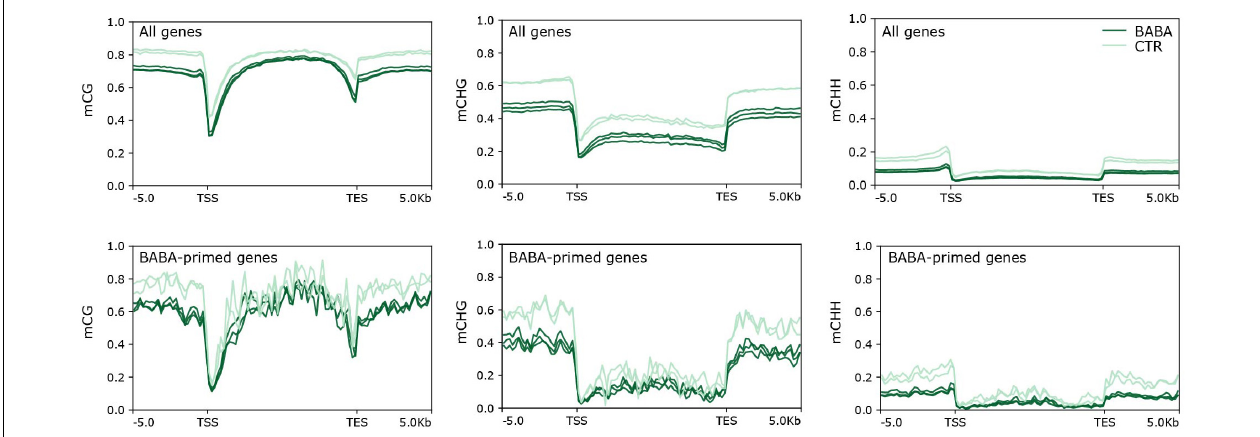
FIGURE 5 | Methylation density alignments for mCG, mCHG and mCHH methylation across standardised profiles for all tomato genes, and for Botrytis -responsive, BABA-primed genes. X-axes show 5 kb distances upstream of the transcription start site (TSS) and transcription end site (TES) of the standardised genes. Plots show proportions of methylated cytosines for control (pale green) and BABA primed (dark green) methylomes.